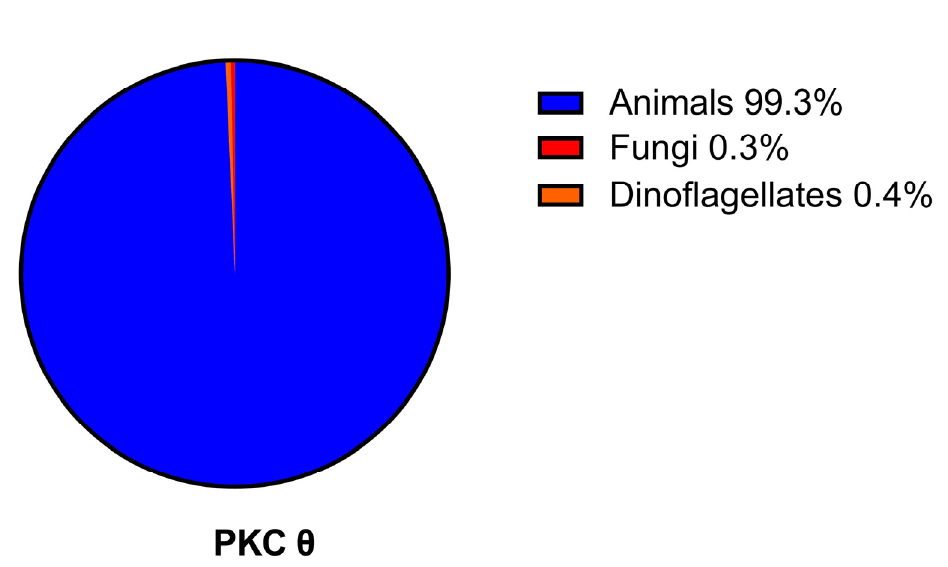
Figure 4. Phylogenetic distributions of the Na + , K + -ATPase α 1 -subunit and PKC θ .